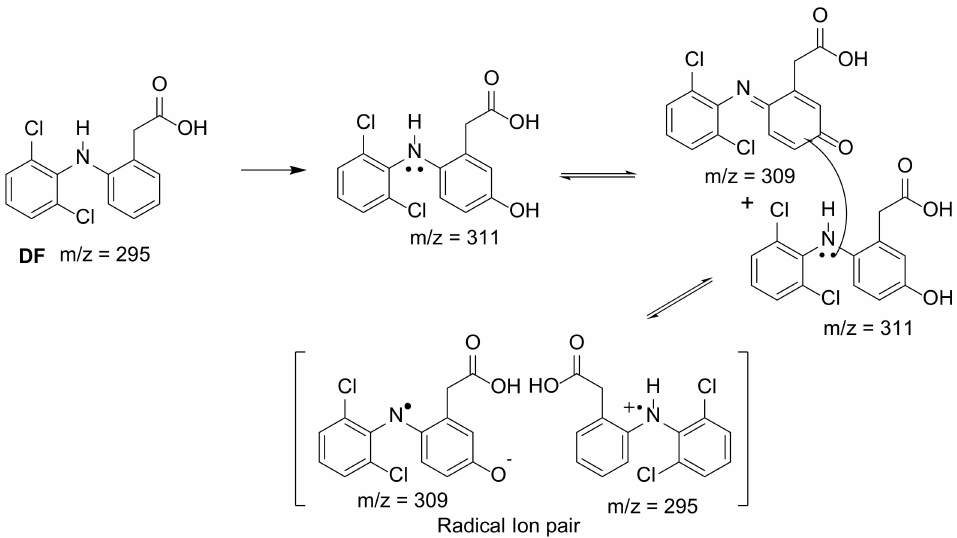
Scheme 7. Proposed pathway for the degradation of diclofenac [55].